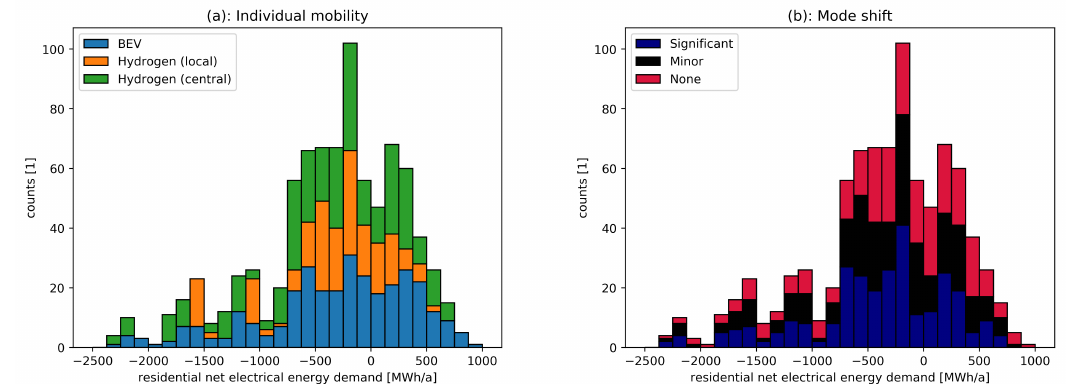
Figure 8. Mobility sector related factors within the scenario space: ( a ) mobility technology; and ( b ) mode shift, which decreases usage of a mobility technology.